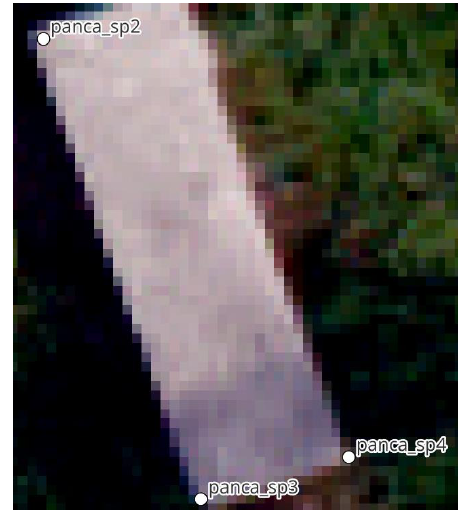
Figure 5. Example of photogrammetric orthoimage with GNSS points.